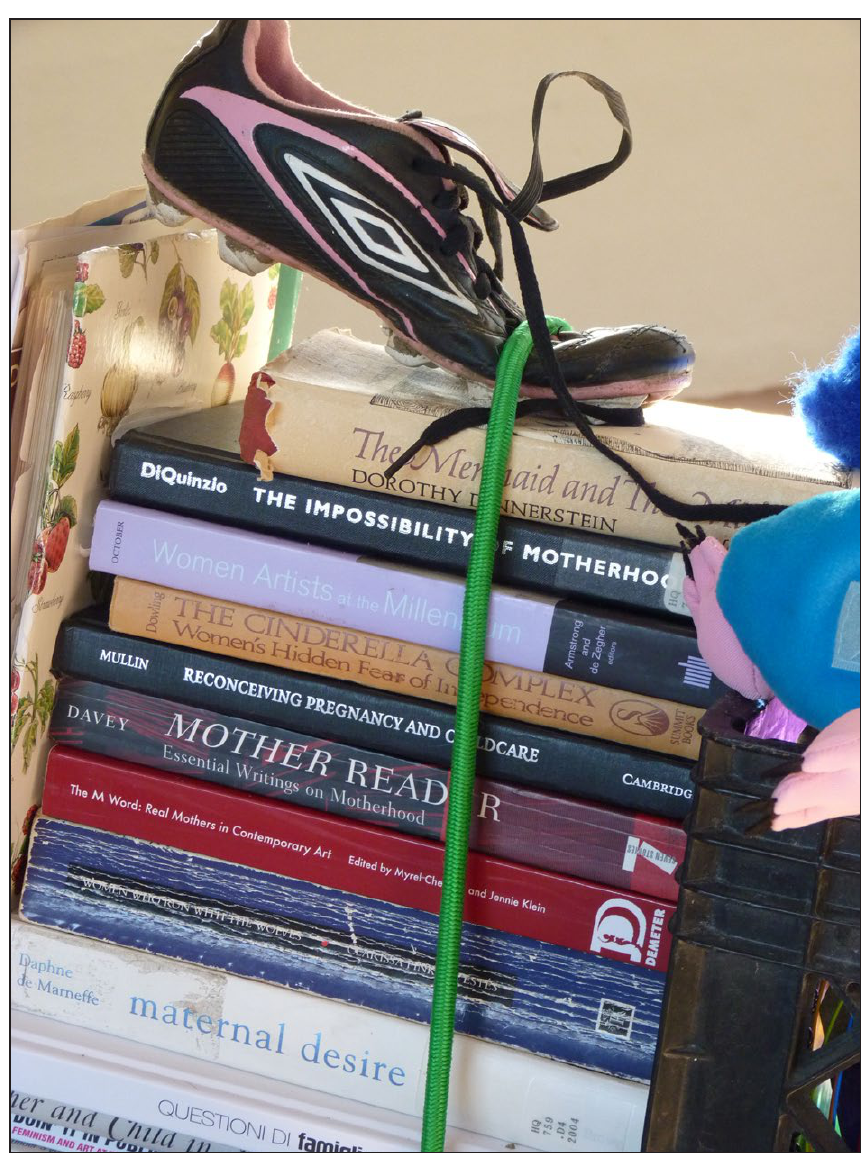
Figure 20: Courtney Kessel, In Balance With (detail), performance, 30 – minutes, 2009